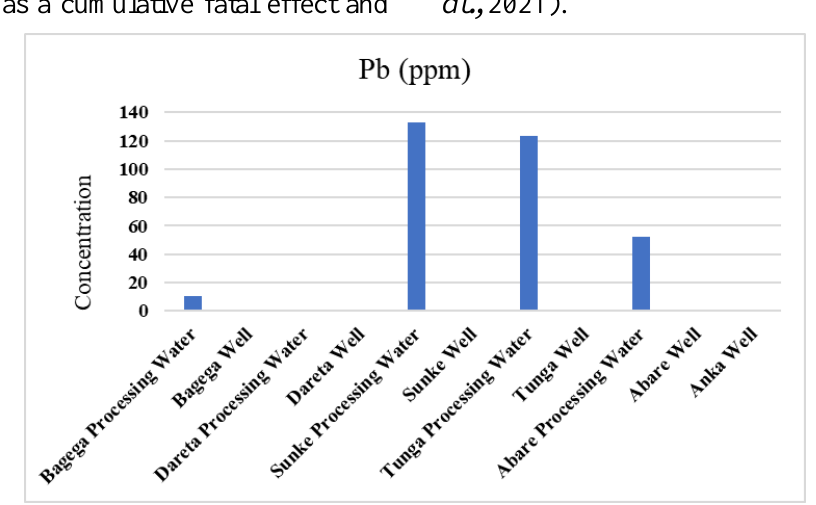
Figure 2. Mean lead (Pb) concentrations (ppm) in water samples of the study area